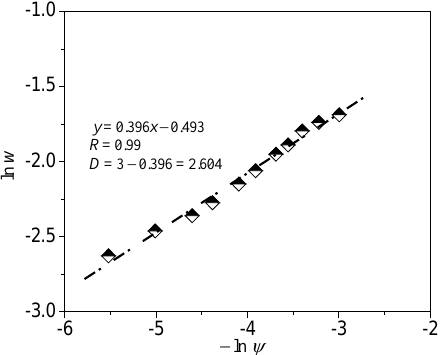
Figure 15. Determination of the values of fractal dimension at reference state through plotting experimental data of ln w against (−ln Ψ ) for Saskatchewan silt (T2) with e 0 = 0.525.